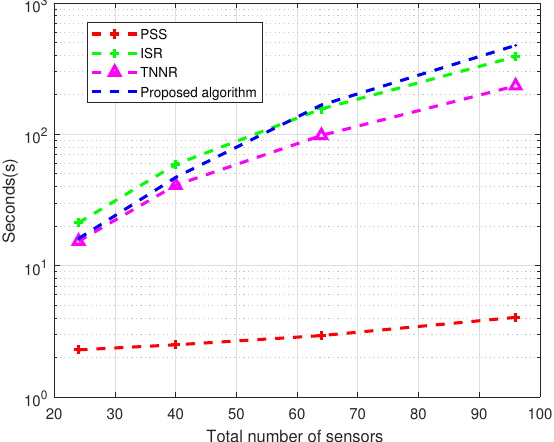
Figure 11. CPU time versus the total number of